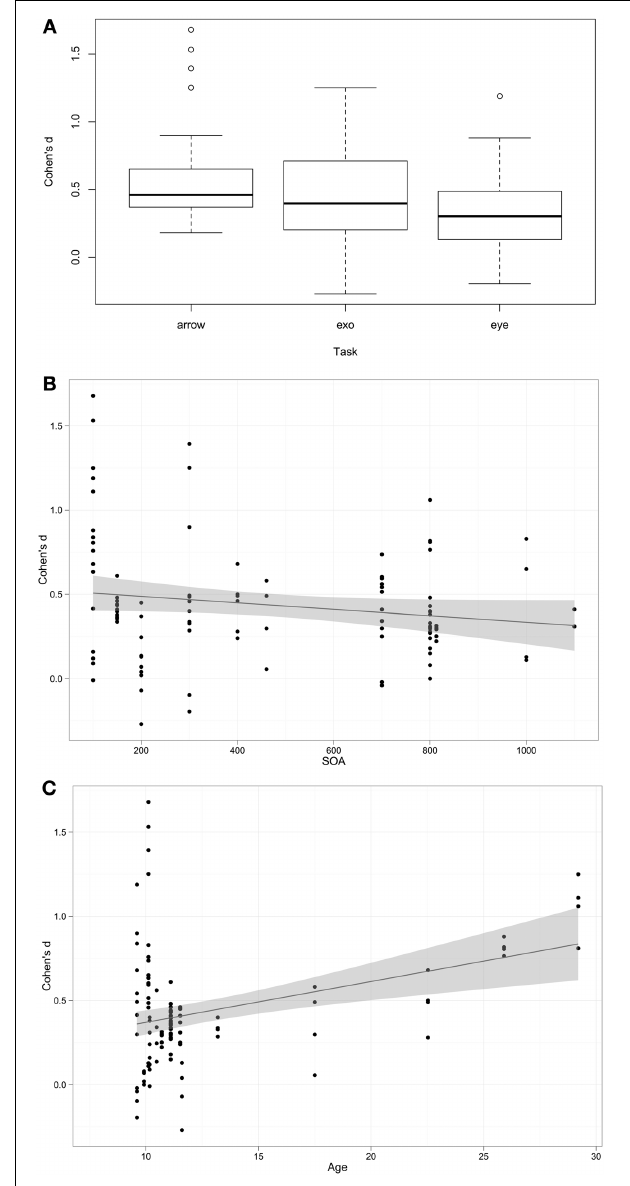
FIGURE 1 | Associations between predictors and orienting magnitude RT among participants with autism. (A) Box-plot of orienting effect across task types. (B,C) Scatterplots with linear regression line of best fit.